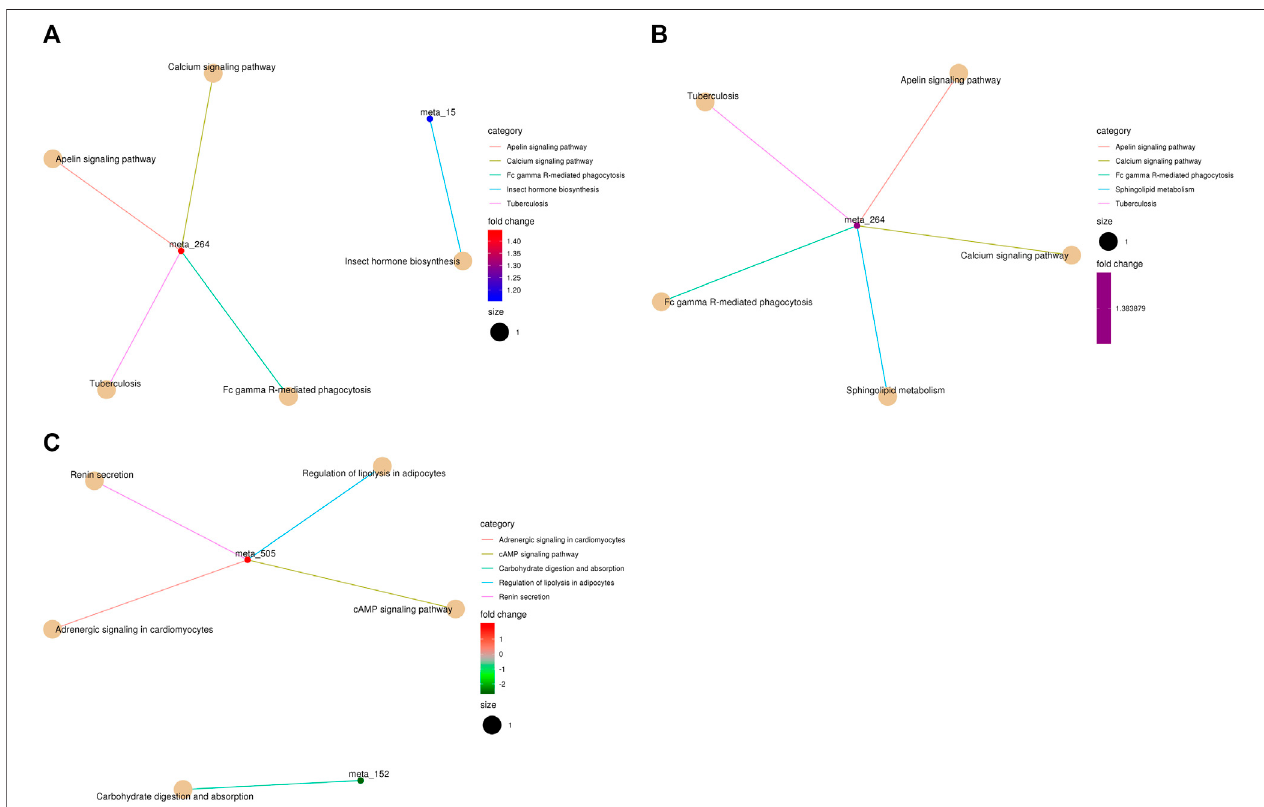
FIGURE 5 | KEGG pathway-enriched cnetplots of differentially abundant metabolites. (A) , NT vs CS2; (B) , NT vs CS6; and (C) , NT vs CS12. (meta_15: farnesy1 pyrophosphate, meta_264: sphingosine-1-phosphate, and meta_505: epinephrine,).